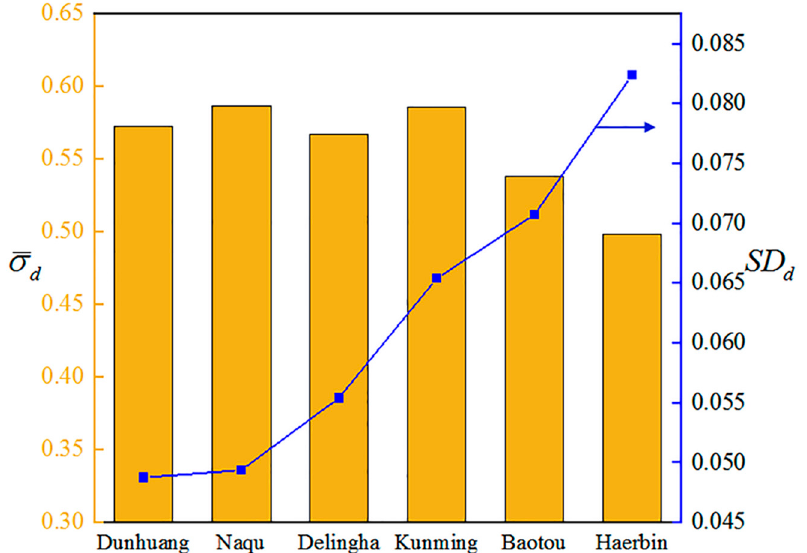
Figure 10. Variation of the daily average effective tracking factor σ d and SD d of an SDC system in different regions. Table 2. Latitude and longitude and the daily average effective tracking factor σ systems in different regions.